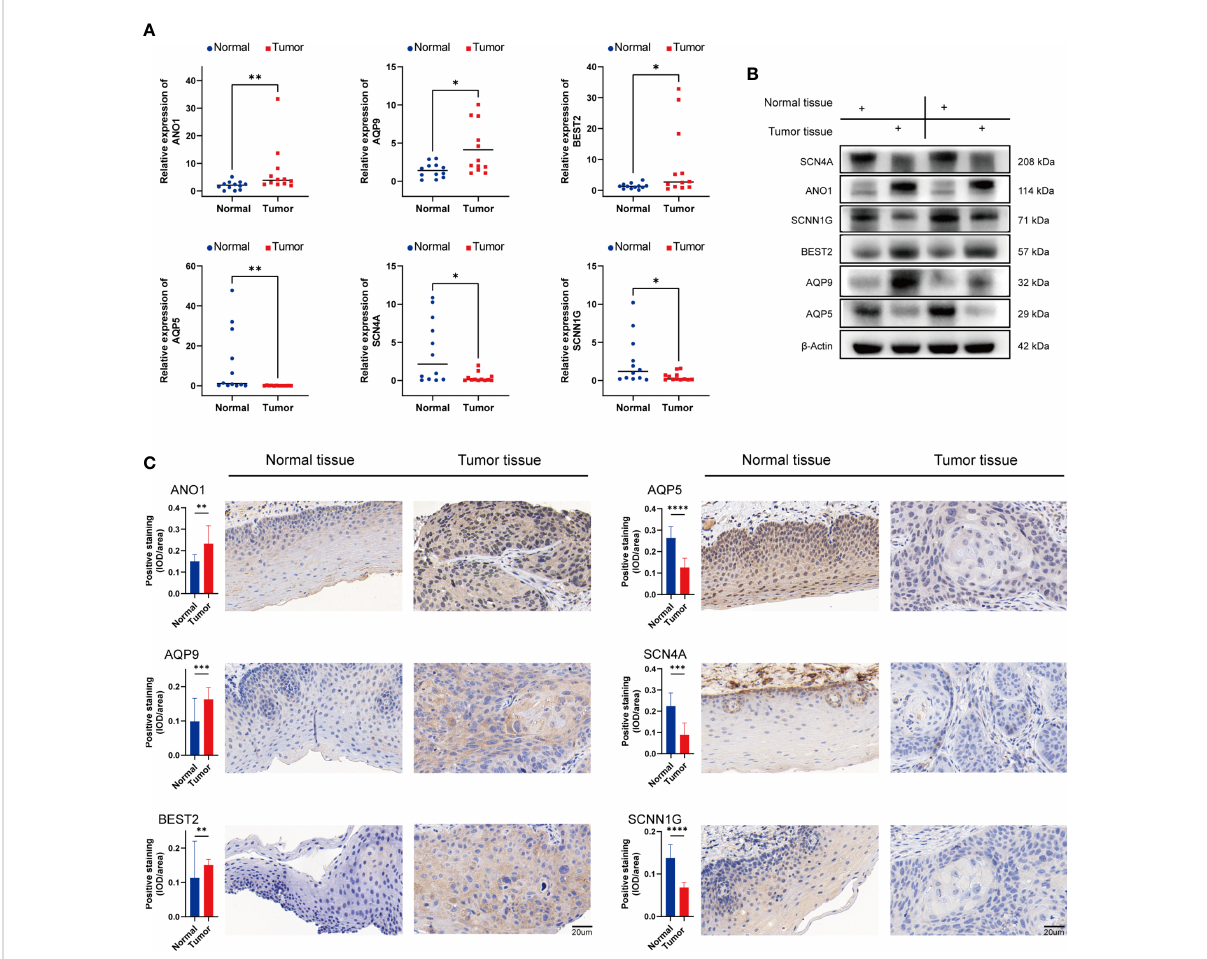
FIGURE 13 Validation of mRNA and protein expression levels of ion channel genes in HNSCC. (A) Comparison of mRNA expression levels of genes in 12 paired HNSCC tissues and adjacent normal tissue samples by qRT-PCR. (B) The western blot analyses. (C) The immunohistochemical staining in 12 paired HNSCC tissues and adjacent normal tissues. IOD, integrated optical density. (*p<0.05, **p<0.01, *** p<0.001,